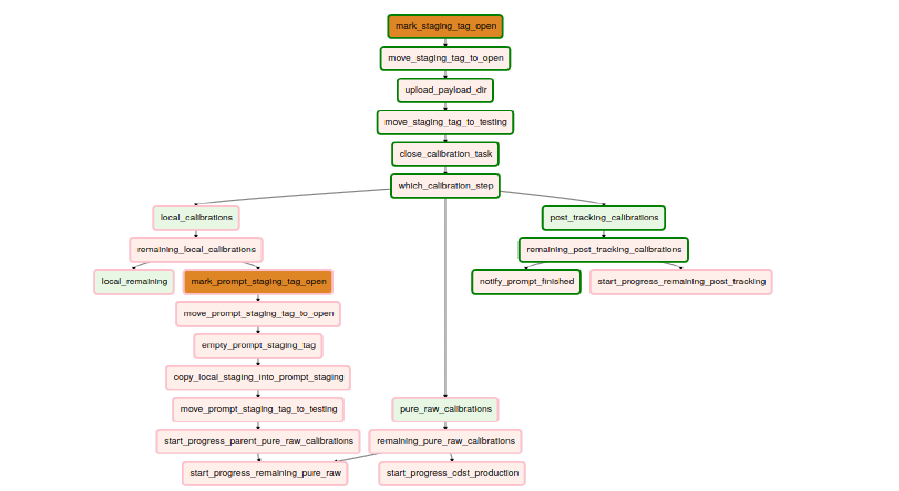
Figure 2. Part of the DAG monitoring page showing the operators that run when a calibration was completed. A green border is a completed process, pink is a skipped process, orange processes are sensors and will not complete until they return a specific value. In this case it was the final calibration of the prompt processing request, so the payloads of the last completed calibration were uploaded and the completion of the prompt processing was notified on a Jira ’Epic’ task.